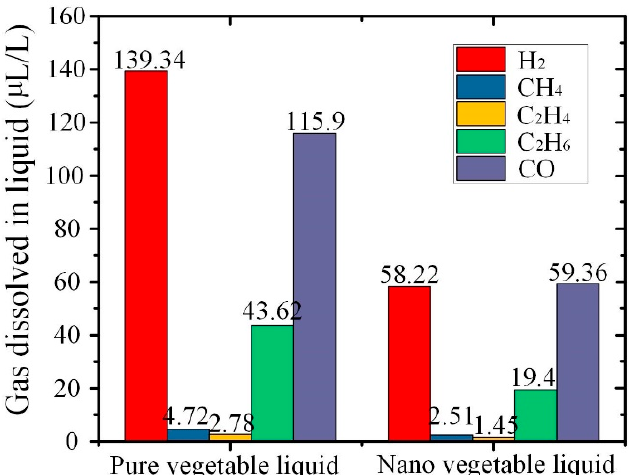
Figure 11. Dissolved gases of vegetable insulating liquid after thermal aging.